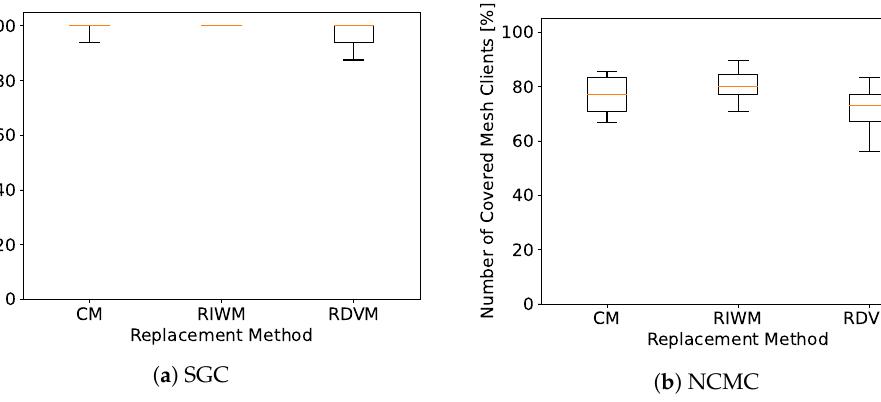
Figure 9. Simulation results of